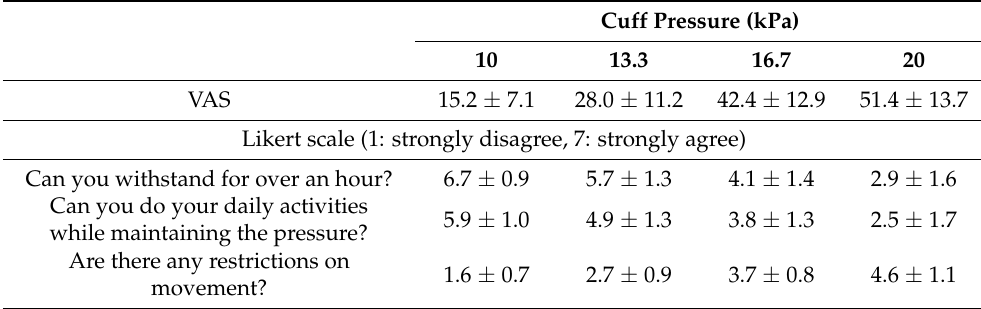
Table 2. Questionnaire responses for each cuff pressure.